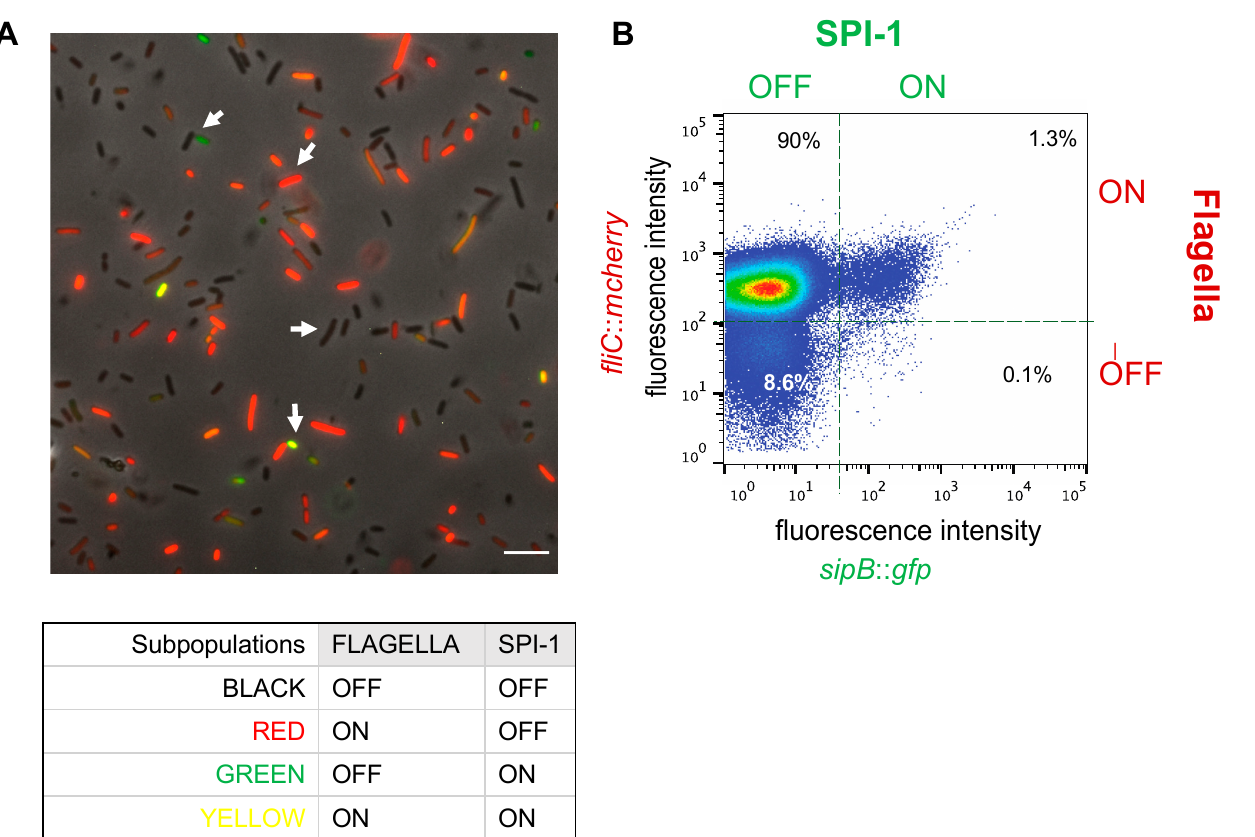
Figure 1. Single cell analysis of expression of SPI-1 (invasion) and flagellar (motility) genes. ( A ) A representative image of S. Typhimurium strain SV8533 ( sipB :: gfp fliC :: mCherry) grown at 37 °C in lysogeny broth (LB) under invasive conditions, visualized by fluorescence microscopy with a 100× objective. SPI-1 and flagellar genes are tagged with GFP and mCherry, respectively. Examples of Table 5. μ m. ( B ) GFP and mCherry fluorescence intensity distribution in an LB culture of strain SV8533 under invasive conditions, monitored by flow cytometry.